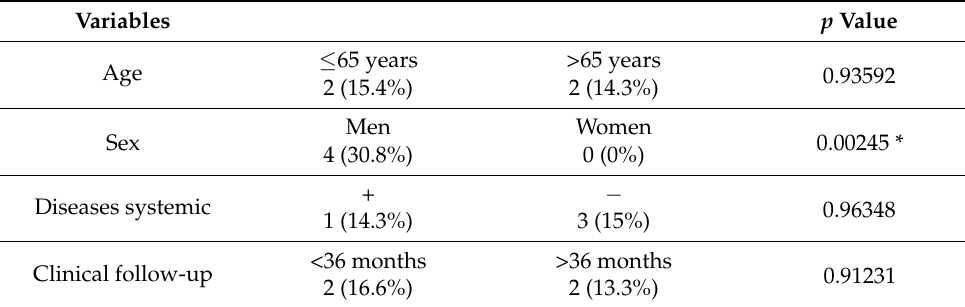
Table 2. Smoker patients ( n = 4, 14.7%).